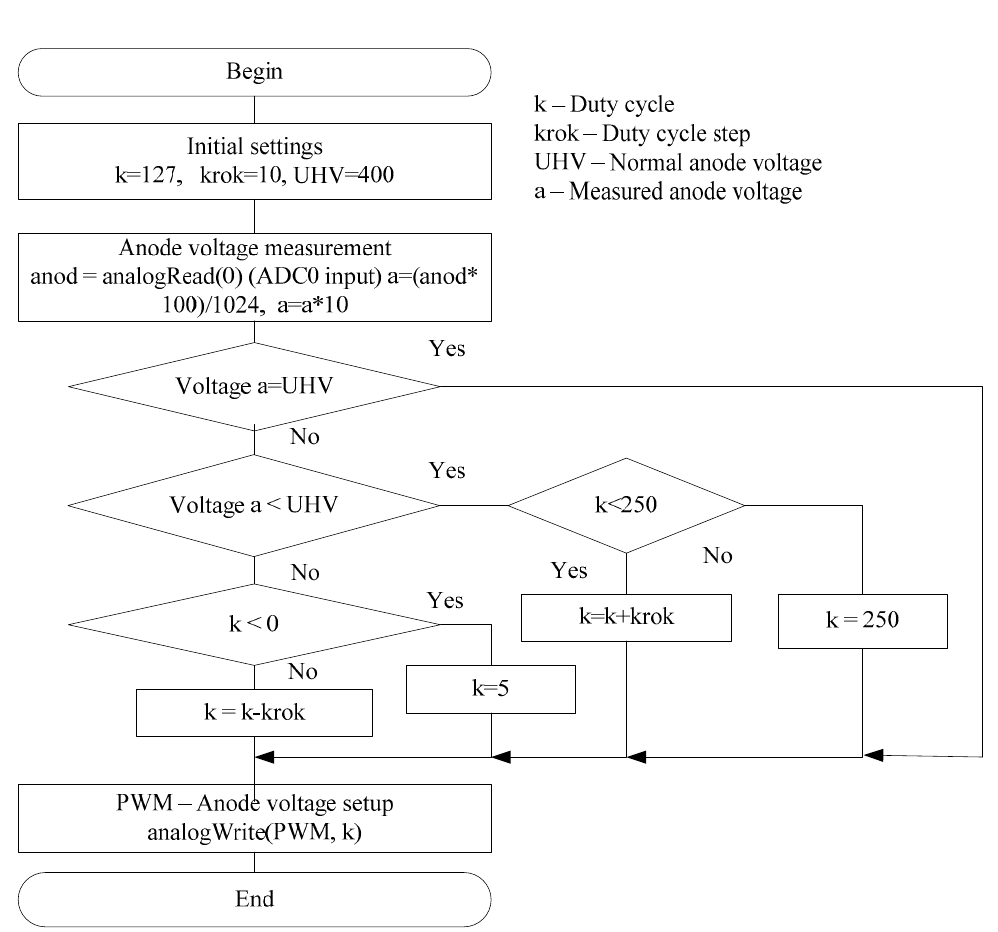
Figure 3. Algorithm of the anode voltage adjustment for the Geiger–Mueller counter.